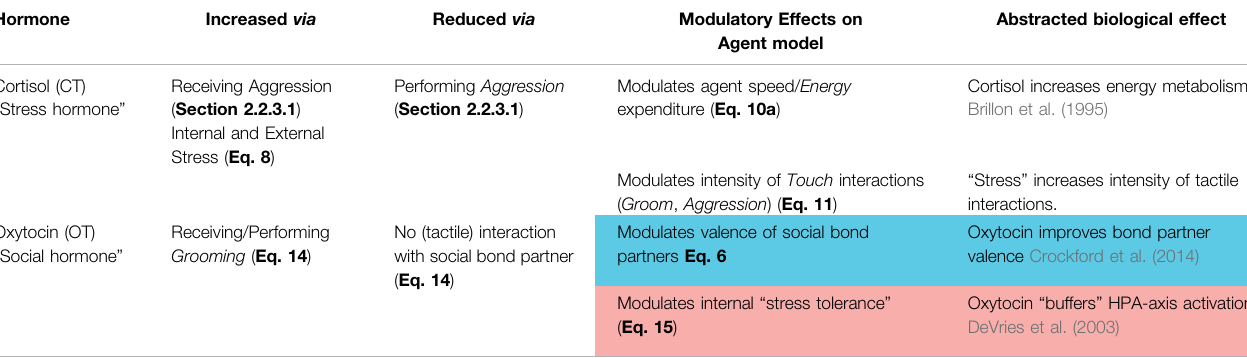
TABLE 2 | Overview of the two hormones in the Affective (Hormonal) System in our agent model: describing how each hormone is secreted (increased), inhibited (reduced), and the modulatory effects they have on agent physiology or behaviour. Number in parentheses are corresponding equation(s) for each effect. Cells in blue denote our abstractions of the two “ social buffering ” effects that we investigate. Hormone Increased via